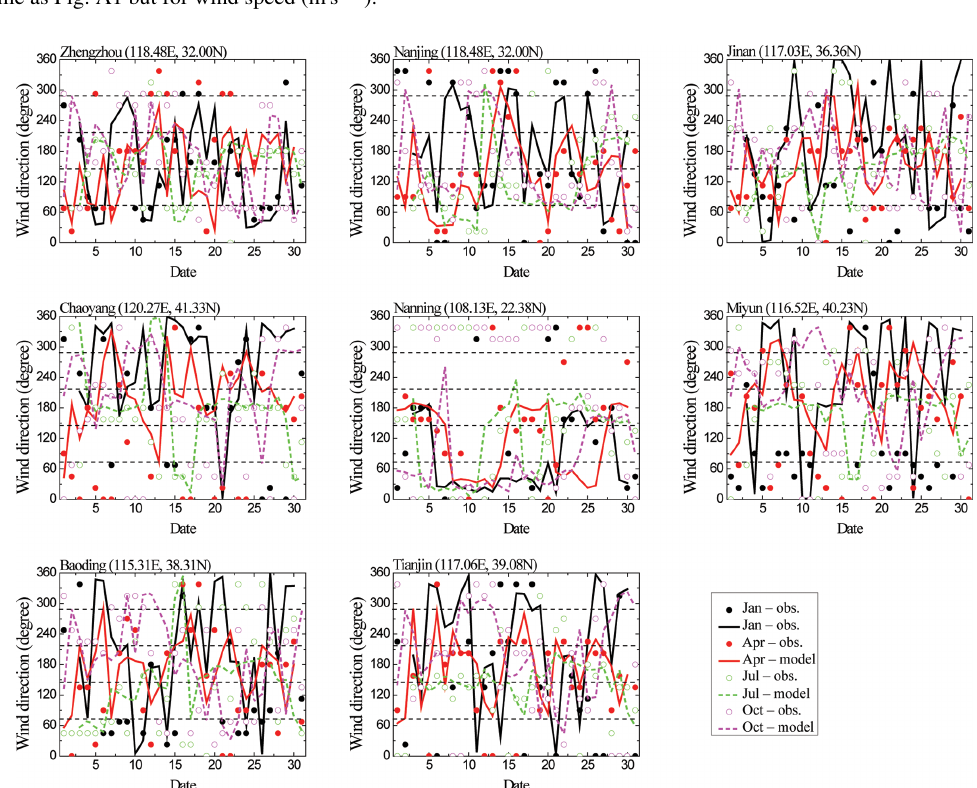
Figure A3. Same as Fig. A1 but for wind speed (ms − 1 ).